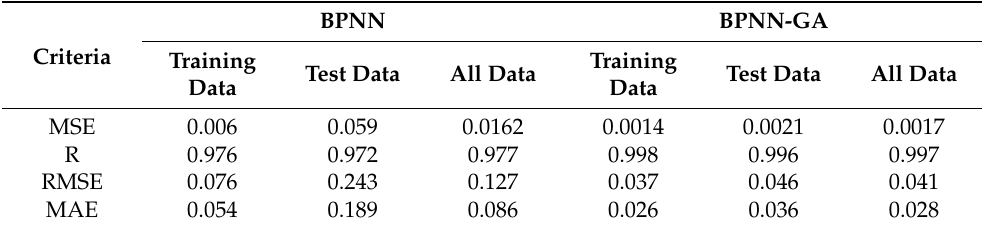
Table 3. Performance criteria for neural network